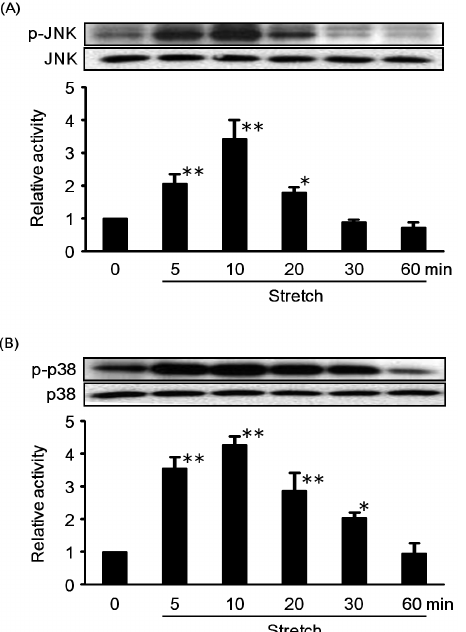
Figure 2. Time course for the effects of cyclic mechanical stretch (15% elongation) on the activation of JNK (A) and p38 (B) in RASMCs. The cells cultured under standard conditions were exposed to cyclic mechanical stretch by 15% elongation for various time periods (from 5 min to 60 min). The phosphorylation of JNK (A) and p38 (B) were measured as described under Materials and Methods . Densitometric analysis of each value was normalized by arbitrarily setting the densitometric value of the control cells (Ctrl.) to 1. Each value represents the mean 6 S.D. (n=3). The asterisks represent significant differences compared with the control value (* P , 0.05, ** P , 0.01).